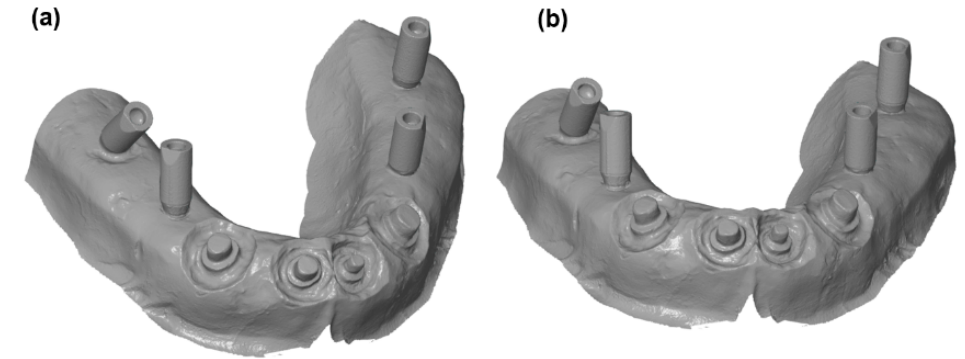
Figure 8. Digitized 3D models obtained using ( a ) Identica Blue and ( b ) D900L commercial 3D scan ‐ ners.